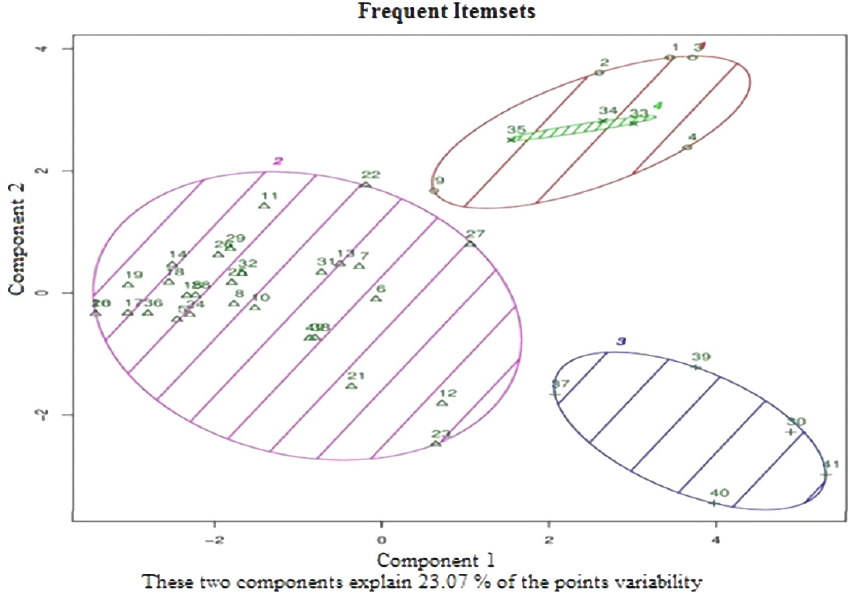
Fig. 10. K -Medoids clustering using frequent itemsets with K ¼ 4